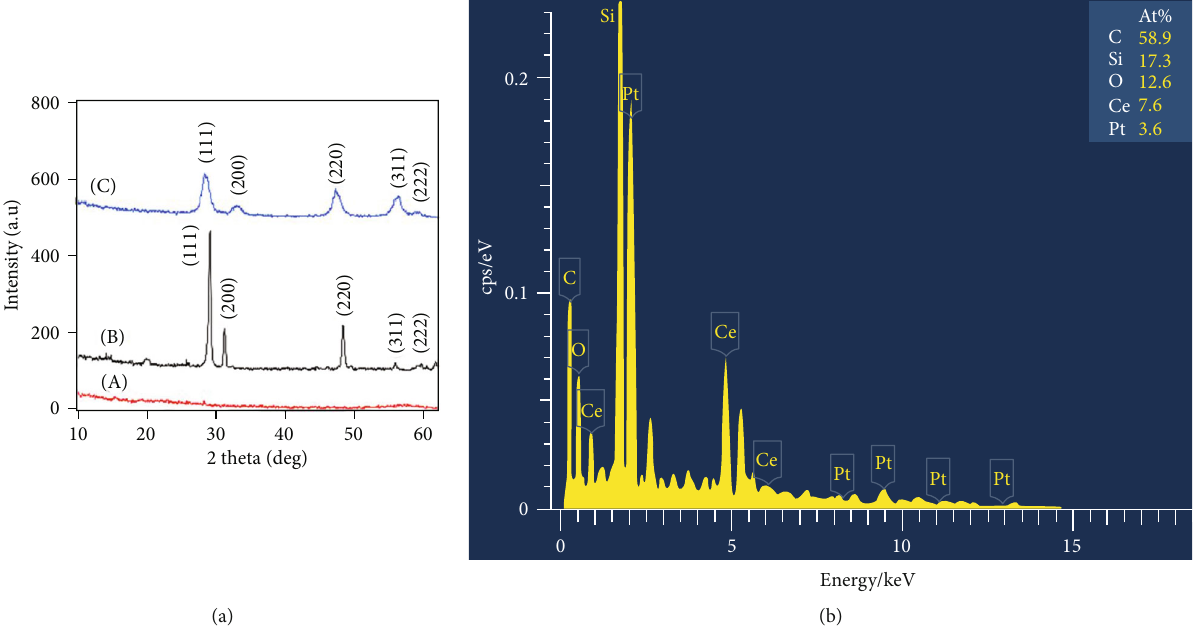
Figure 2: (a) XRD patterns of (A) pure PPy, (B) pristine CeO